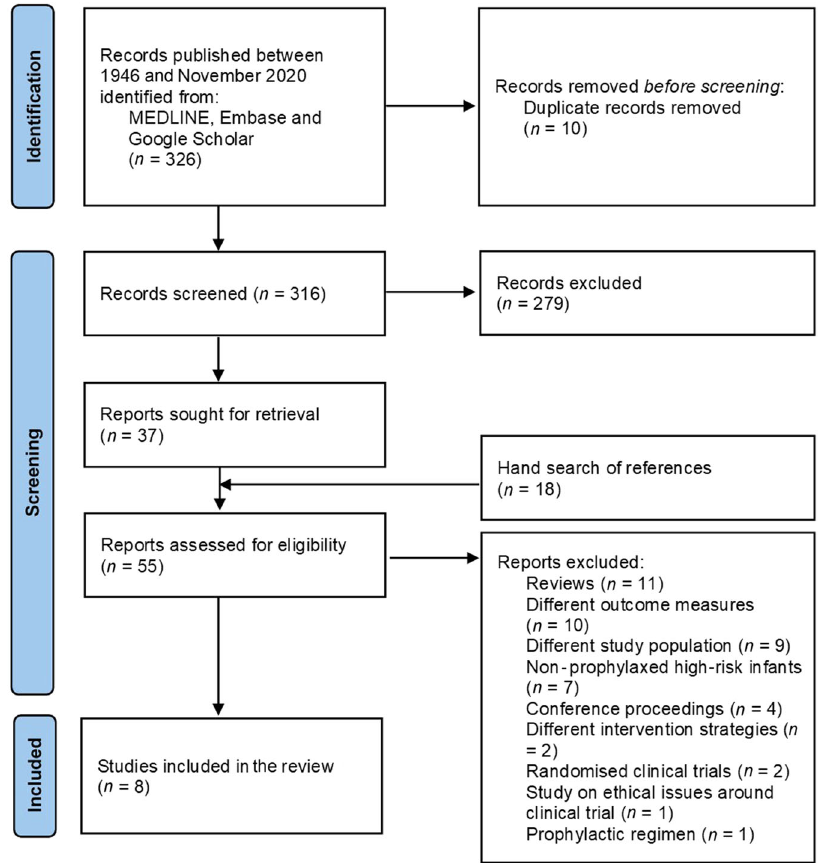
Fig. 1 Study selection fl ow